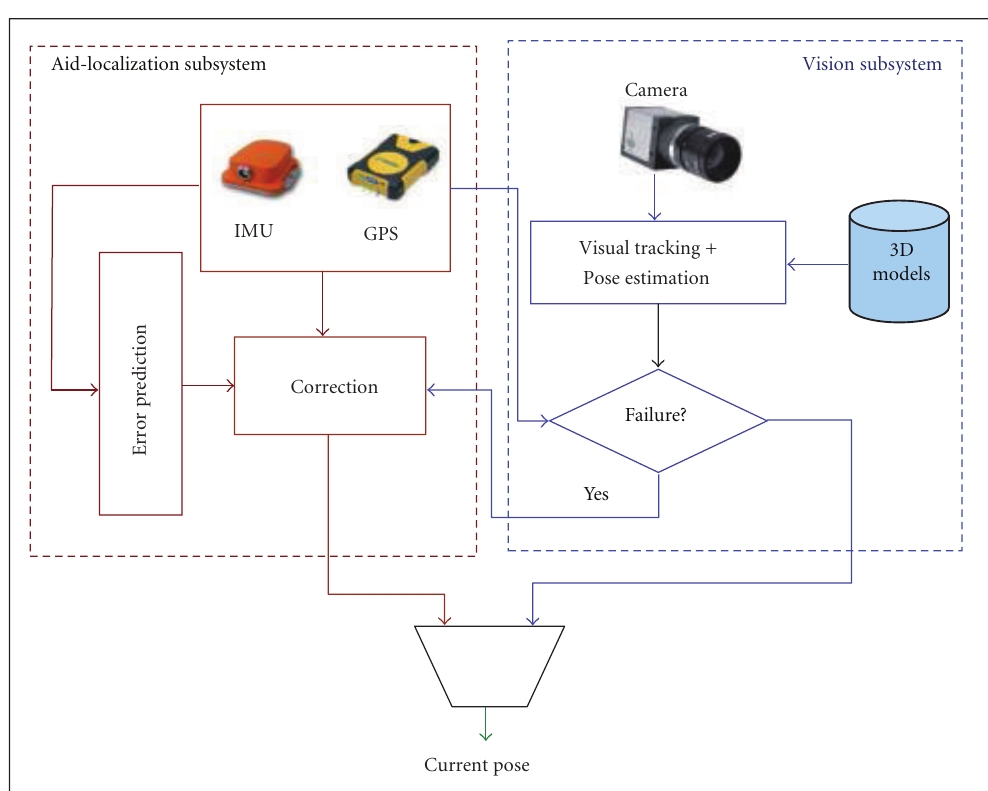
Figure 2: The system data flow